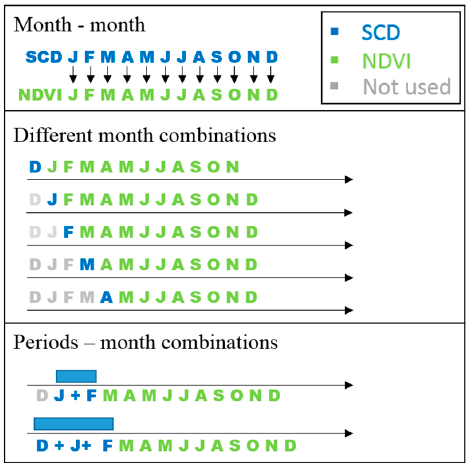
Figure 3. Schematic representation of the different pixel ‐ wise correlation approaches.